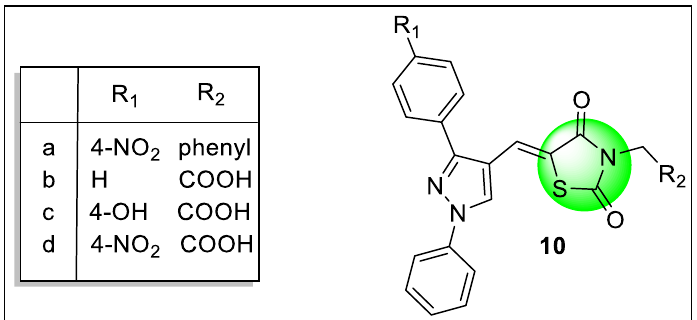
Figure 12. Series of thiazolidinedione hybrids ( 10 ) as potent PPAR ligands.